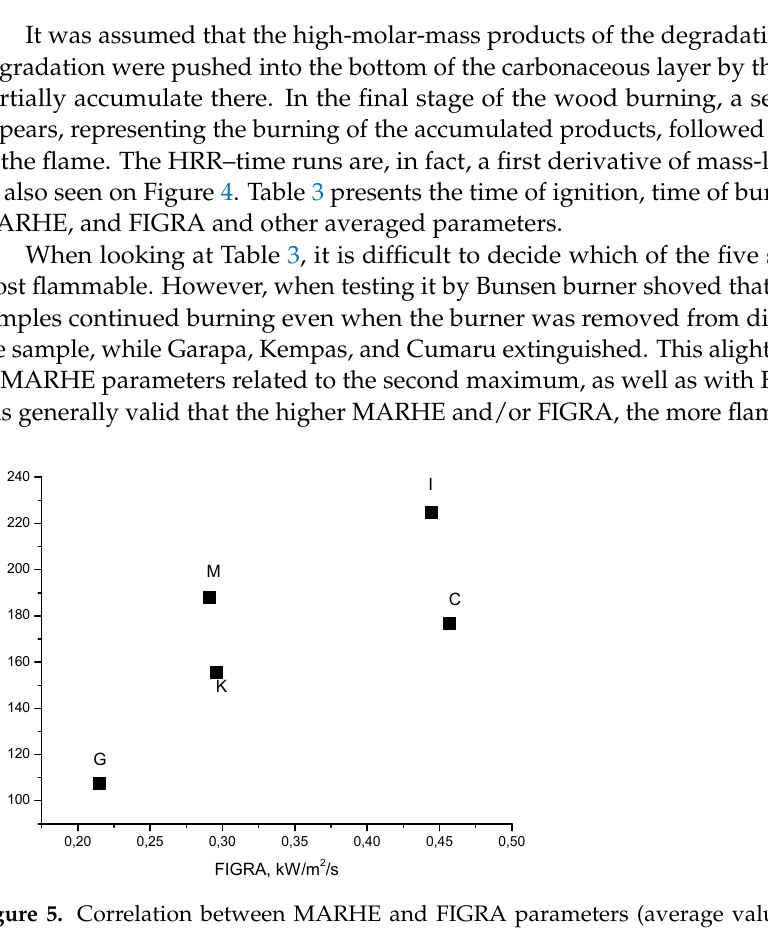
Figure 4. The average HRR–time and mass-loss runs (from 4 parallel experiments) at 35 kW/m 2 for Cumaru.